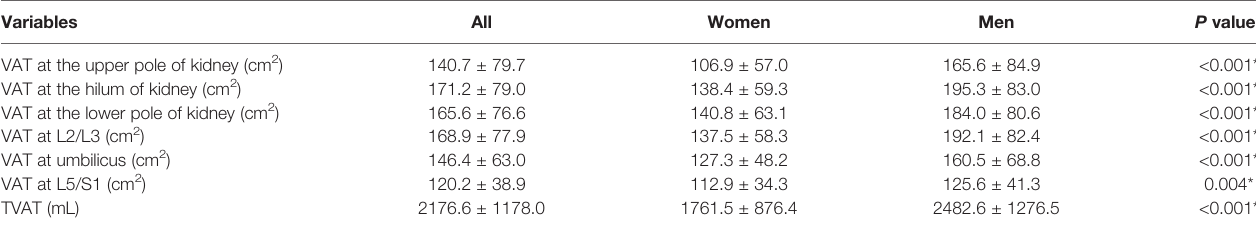
TABLE 3 | Variations of VAT among slices at different anatomical locations and TVAT. Variables All